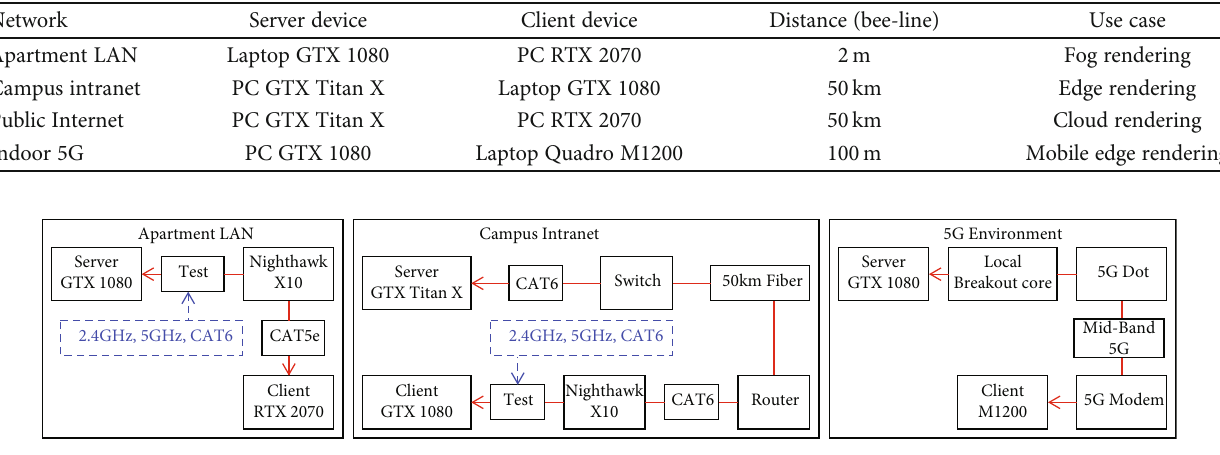
Figure 2: Layout of apartment, intranet, and 5G experiments.